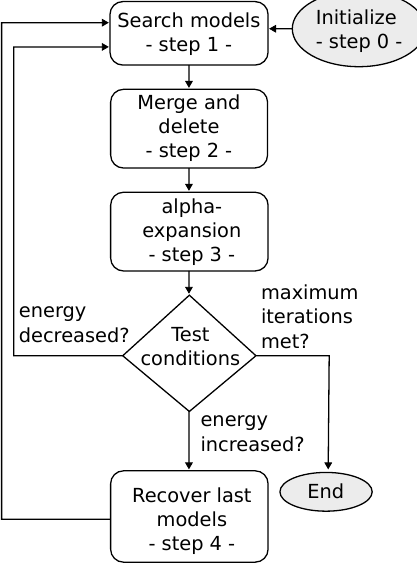
Figure 3. Overview of the Ruby